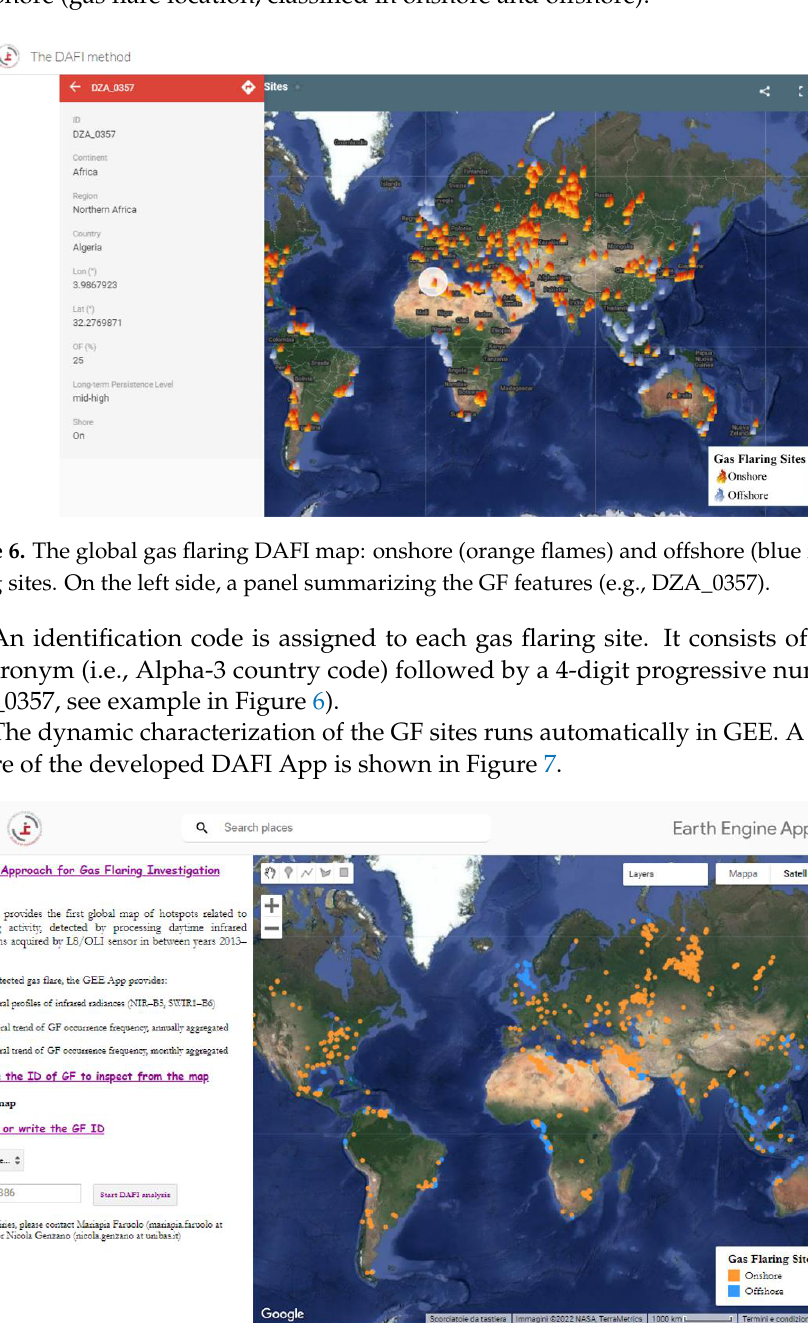
Figure 7. DAFI GEE App picture.